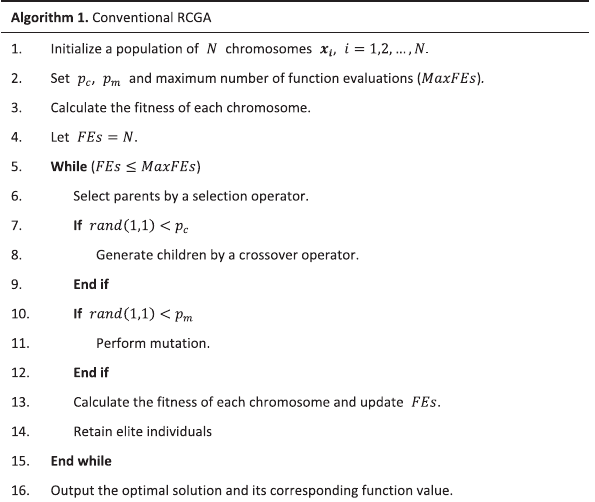
TABLE 1 | The pseudo-code of conventional RCGA